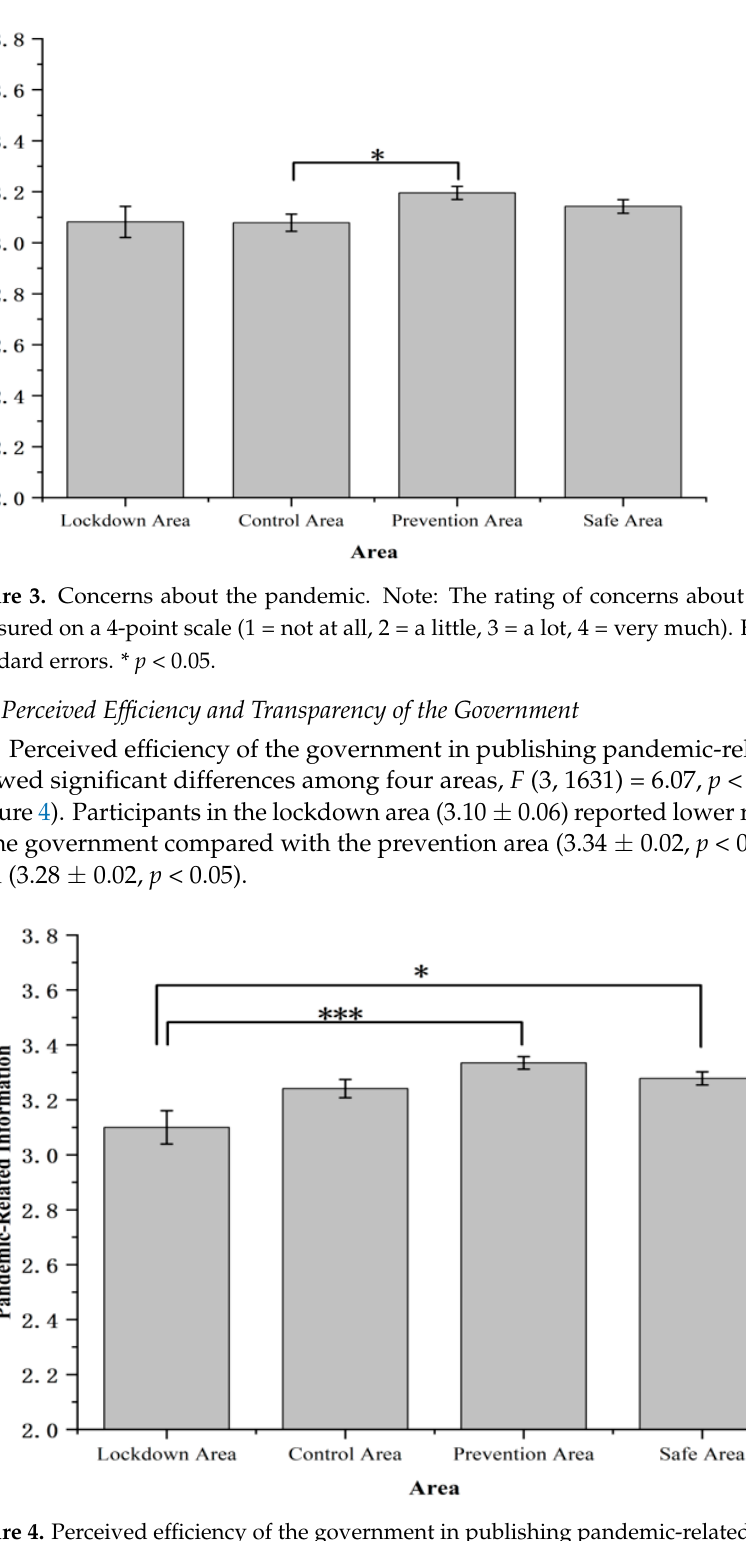
8 of 18 Figure 2. Time in reading or searching for pandemic-related information. Note: The rating of time in reading or searching for pandemic-related information was measured on a 5-point scale (1 = less